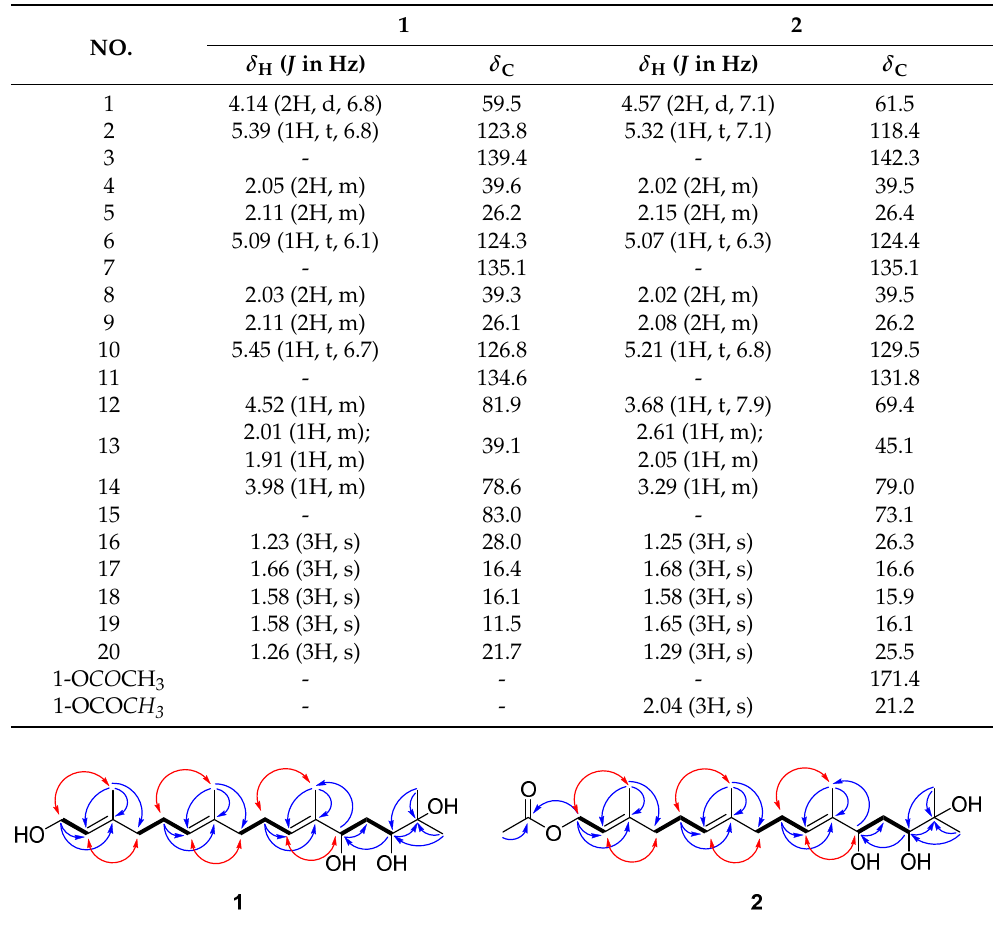
Figure 2. Key 1 H- 1 H COSY (bold lines), HMBC (blue arrows), and NOESY (red arrows) correlations of compounds 1 and 2 .